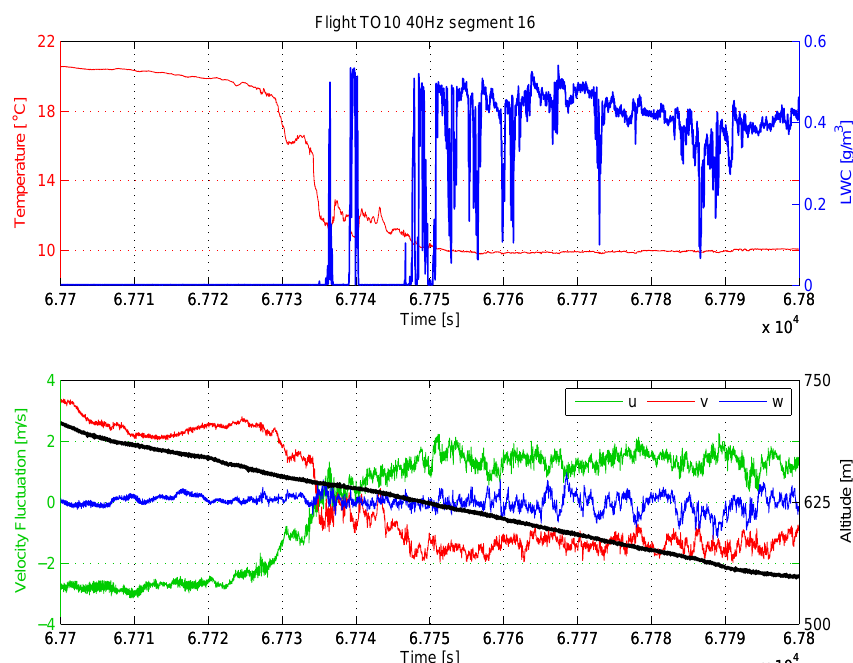
Fig. 4. Temperature T , liquid water content LWC, and velocity fluctuations (mean values subtracted) in the course of a descent into the stratocumulus cloud deck, illustrated by the altitude (black line), during flight TO10.